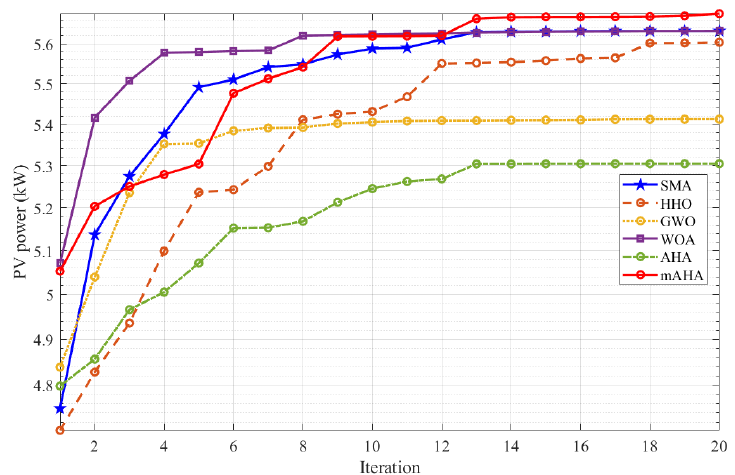
Figure 6. Mean cost function variation during optimization process for first shadow scenario.